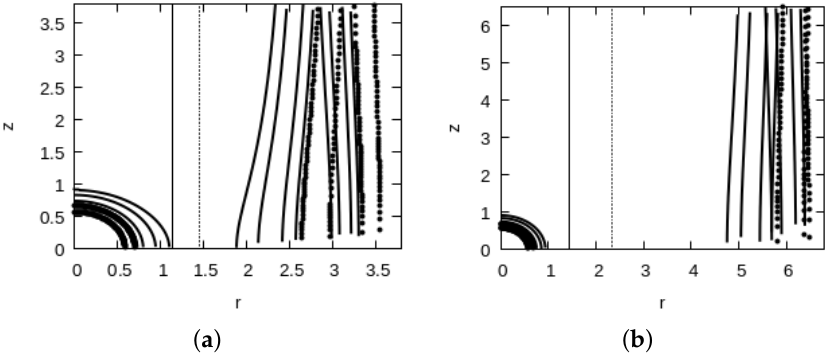
Figure 3. Potential Φ cg contour curves for a Keplerian disk. This is the centrifugal-gravitational potential associated with poloidal magnetic surfaces. Vertical full lines indicate the position of the BH horizon. The dotted lines indicate the ISCO position (i.e., the disk’s inner radius, where orbits are still allowed to keep their stability). In ( a ), a = 0.98 indicates that the lines of the magnetocentrifugal winds are approaching the BH horizon and could be a source of particle flow that collides with other particles close to the BH. In ( b ), the black hole spin is a = 0.9, and the magnetocentrifugal winds are too distant from the horizon to form a flow of colliding particles. Here, r in is calculated from the r ms Kerr radius in natural